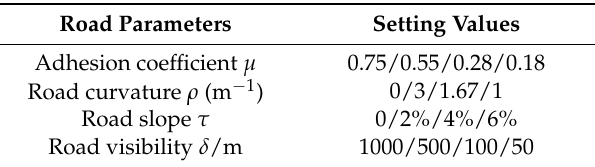
Table 1. Settings of Road